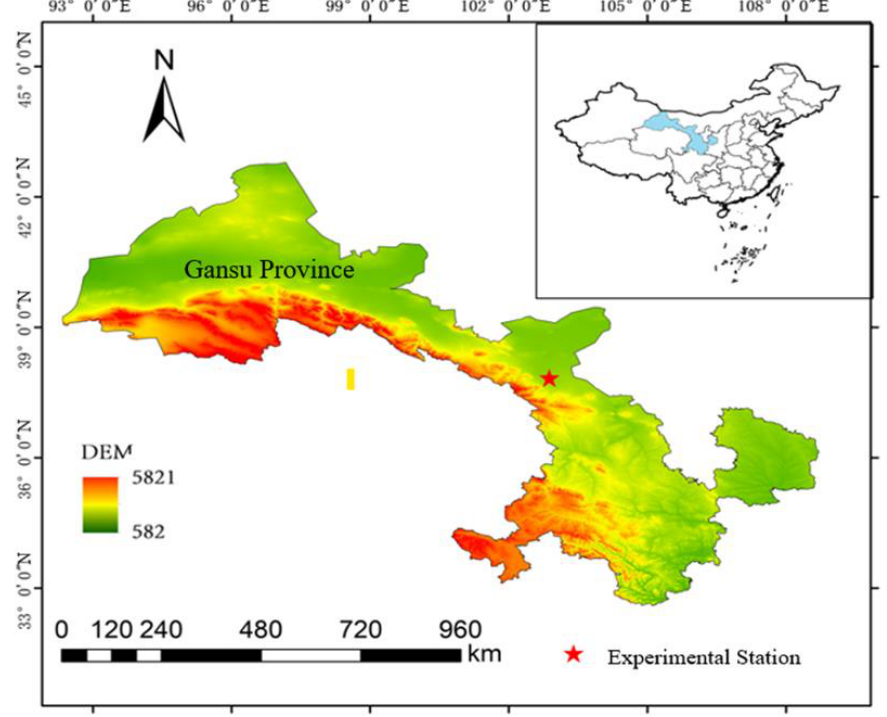
Figure 1. Location of the experimental station in Wuwei, Gansu,